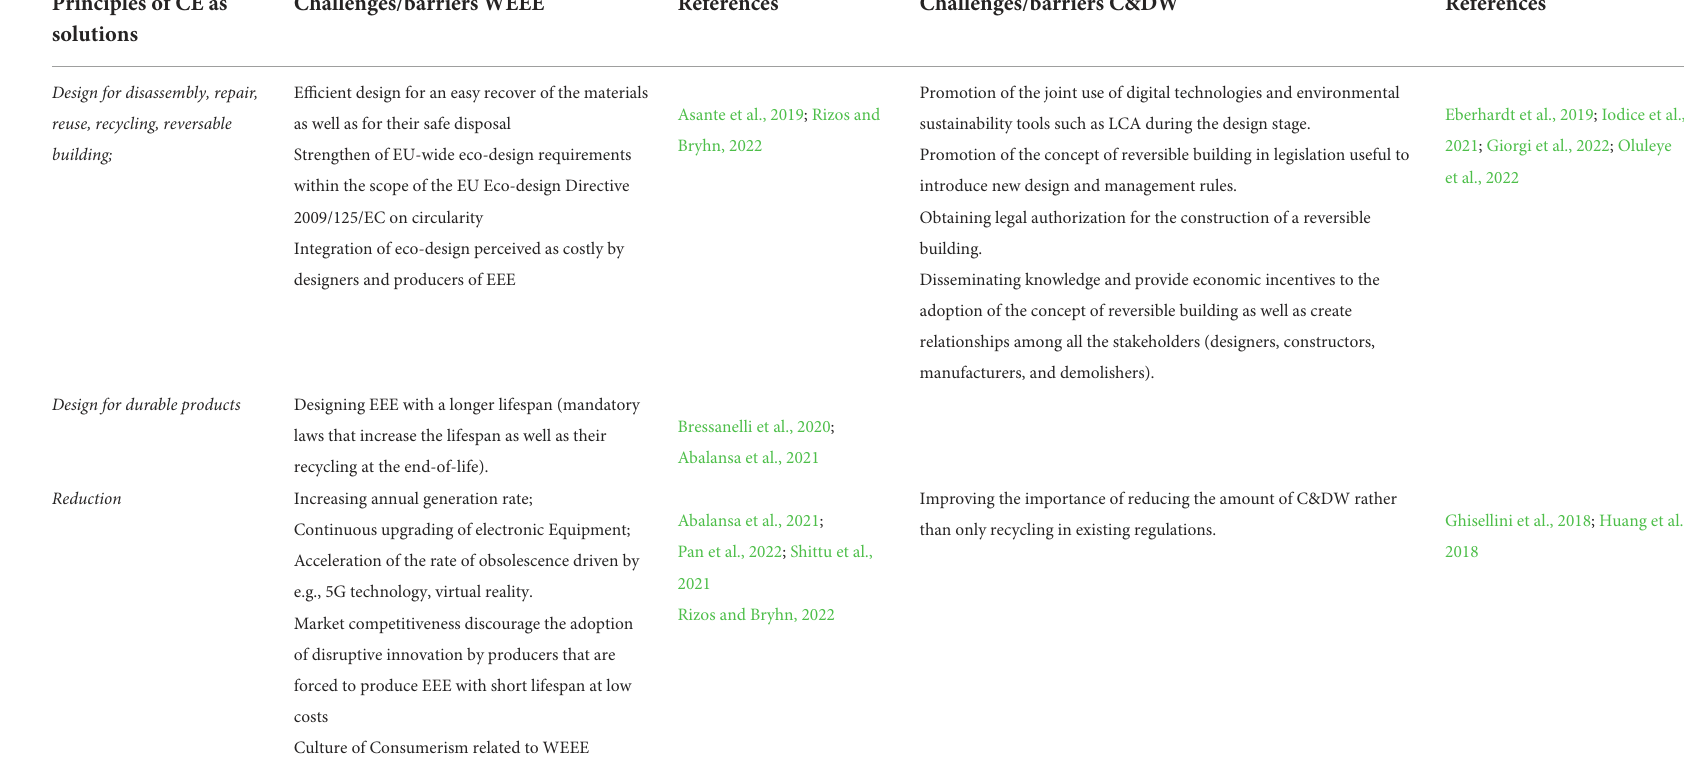
TABLE 2 A summary of the main CE principles and related challenges/barriers retrieved from the literature about WEEE and C&DW sectors. Principles of CE